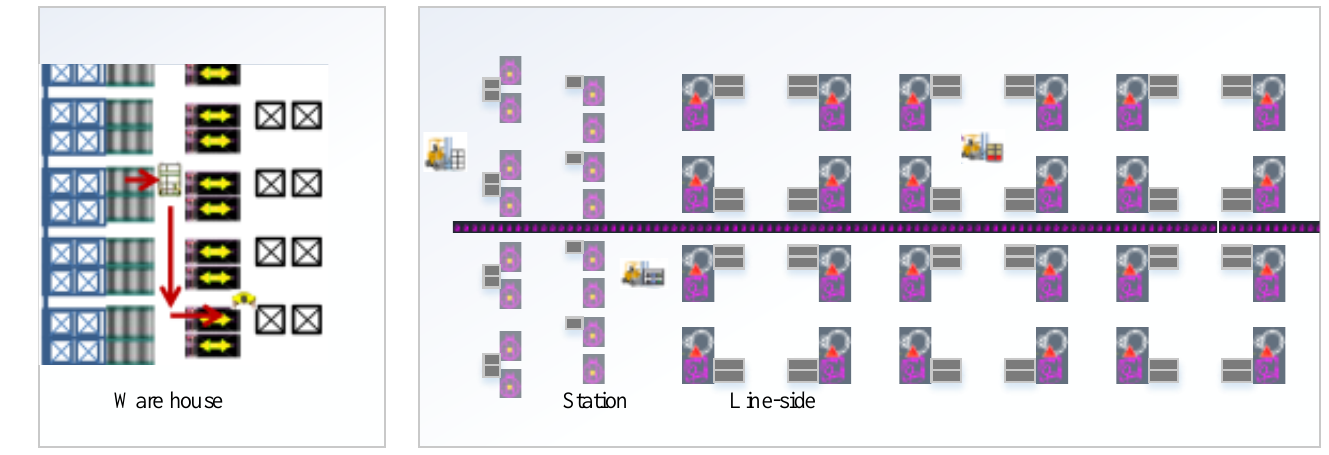
Figure 11. Logistics distribution diagram of automobile assembly workshop.